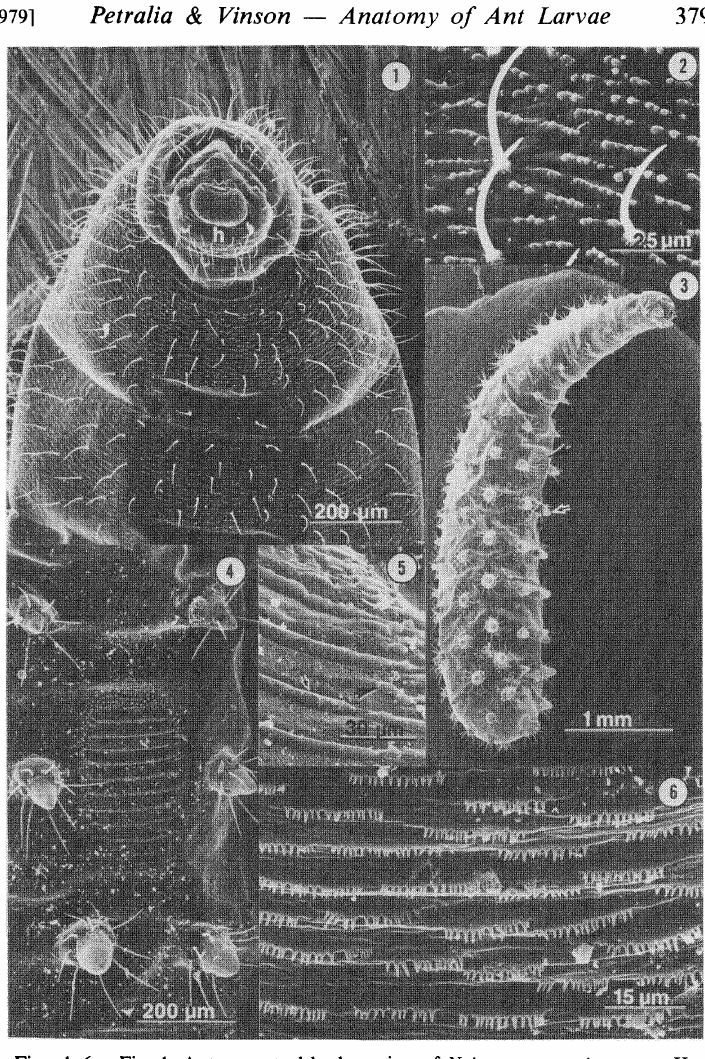
Figs. 1-6. Fig. 1. Anteroventral body region of Neivamyrmex nigrescens. Head (h). Fig. 2. High magnification, from Fig. of N. nigrescens, of hairs and rows of spinules. Fig. 3. Leptogenys elongata showing ventral ridged structure (large arrow) on 3rd abdominal segment and tubercles (small arrow). Fig. 4. High magni- fication, from Fig. 3 of L. elongata, of ridged structure and tubercles. Fig. 5. High magnification of ridged structure of L. elongata showing ridges (small arrow) and papillose protuberances (large arrow). Fig. 6. Posteriorly pointing ventral mesotho- racic spinules of L.